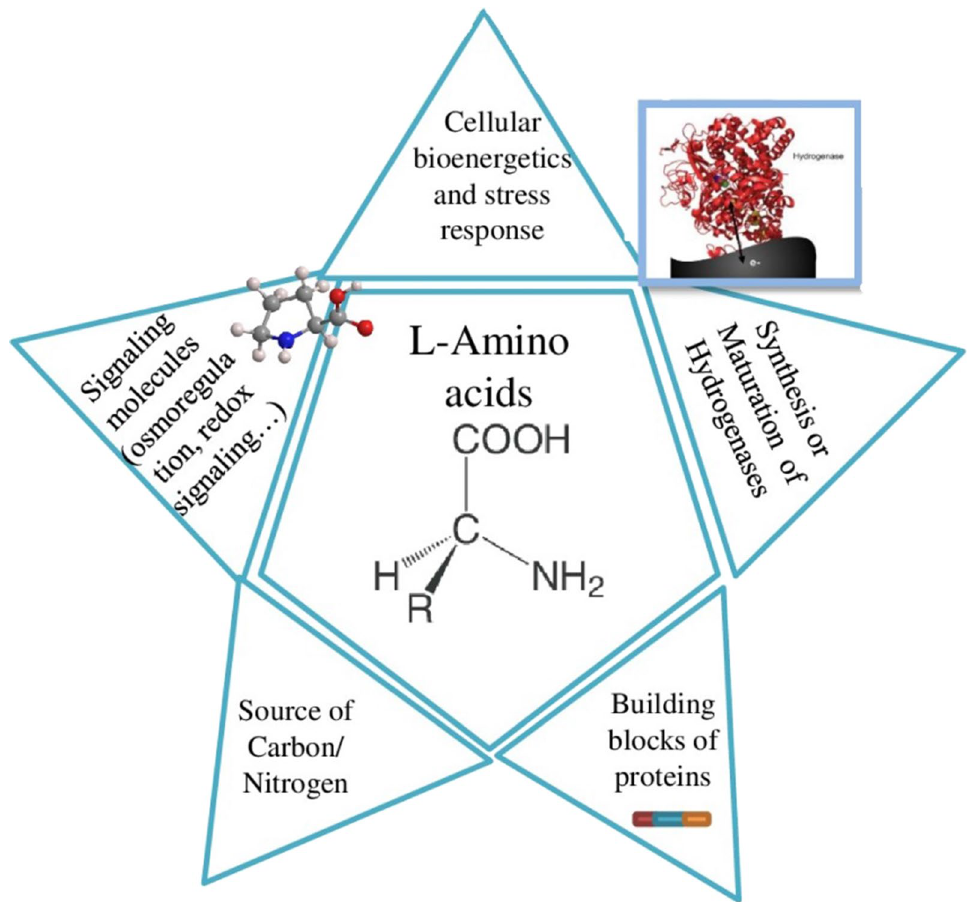
Fig. 6 Schematic presentation of the effects of l -Amino acids on the metabolism of